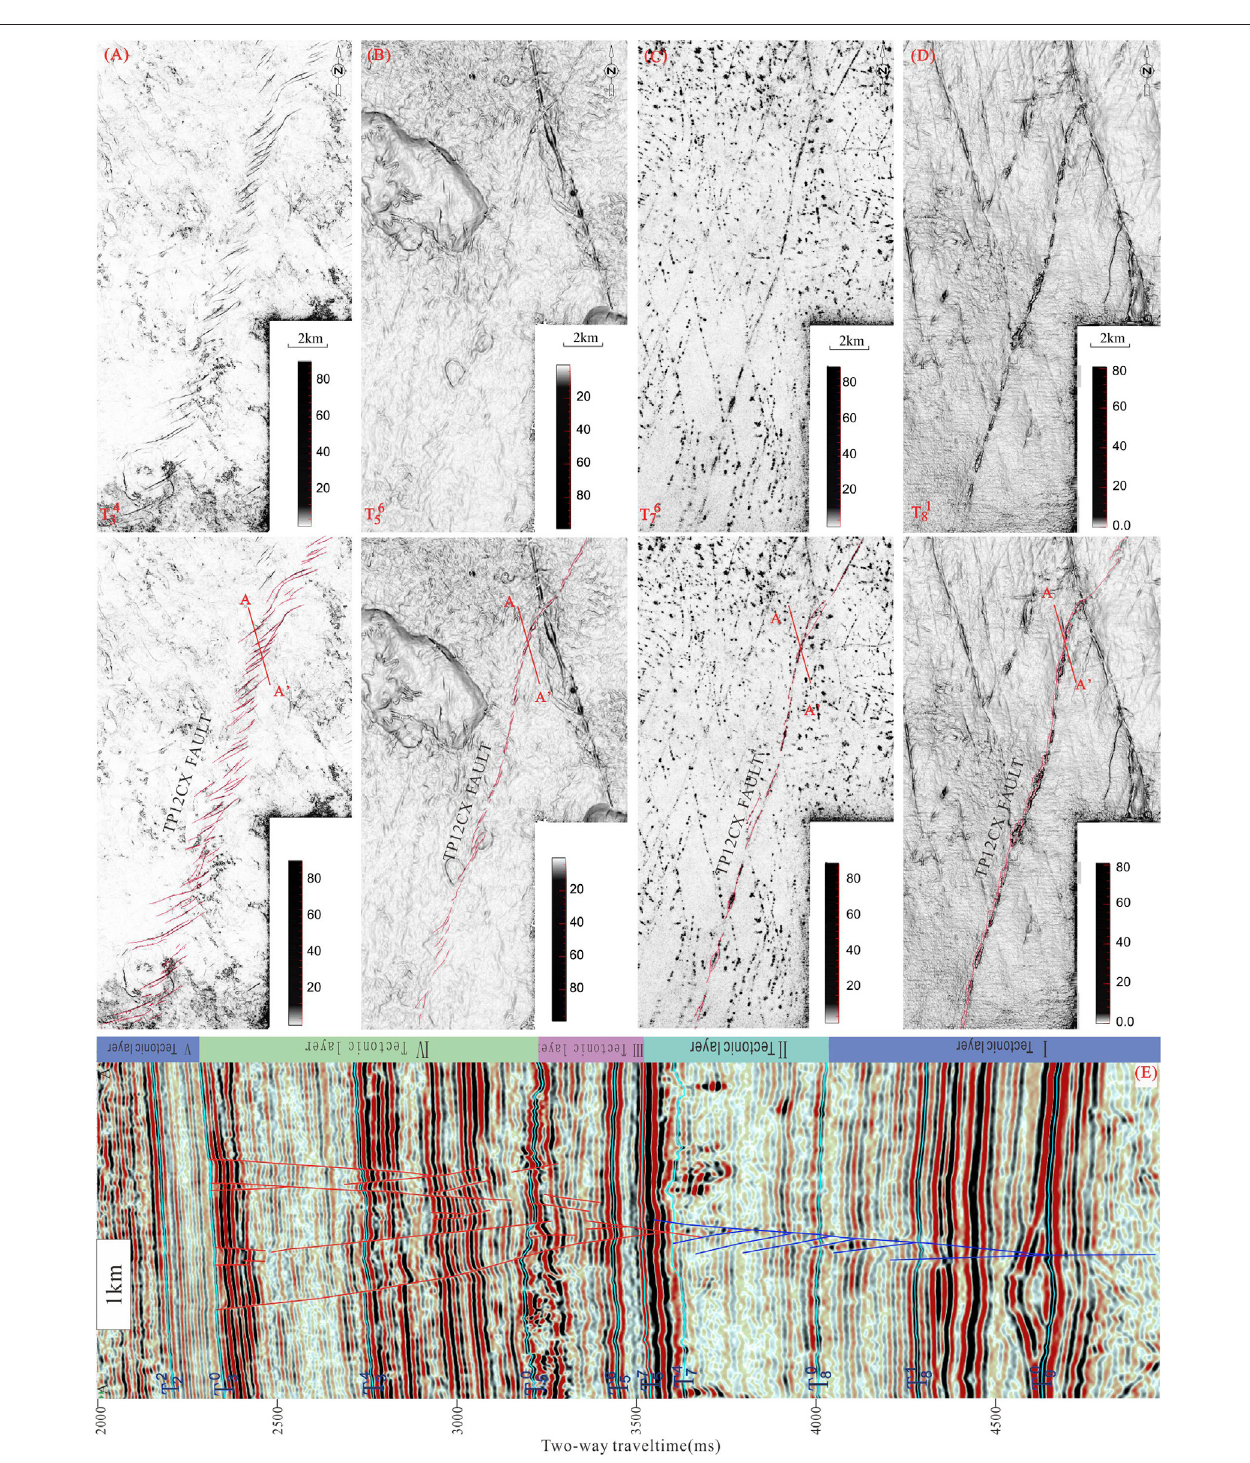
FIGURE 3 | Uninterpreted coherence slices(top images in (A – D) ) and interpreted coherence slices (middle images in (A – D) ), The middle image, AA ′ , shows the location of the seismic section located at the bottom. (A) coherence slice of surface T34. (B) coherence slice of surface T56. (C) coherence slice of surface T76. (D) coherence slice of surface T81 and (E) AA ’ section of TP12CX fault.